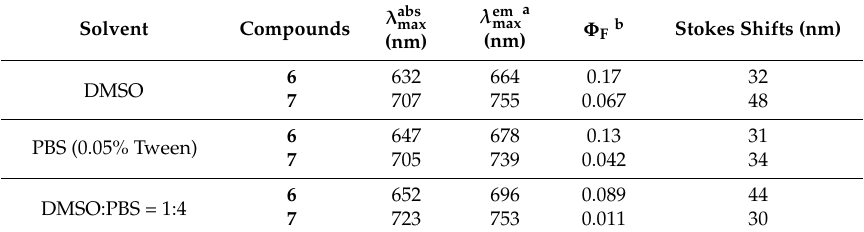
Table 1. Photo-physical/photo-chemical data of compounds 6 and 7 in different solvents. Solvent